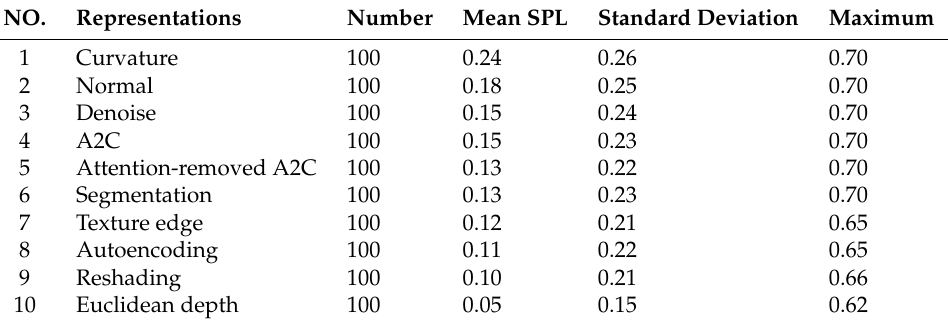
Figure 7. Number of collisions caused by agents with different state representations in the testing environments. Table 5. (Sorted by mean success weighted by path length (SPL) in descending order) SPL obtained by agents with different state